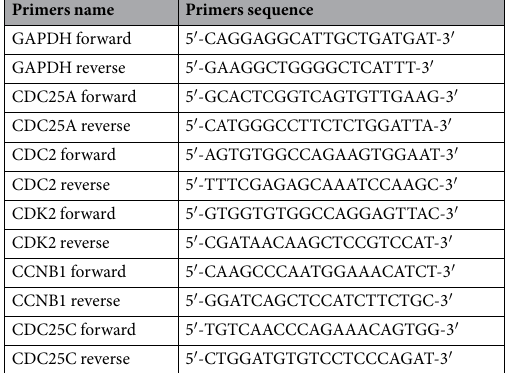
Table 1. Primers used for Quantitative Real-time